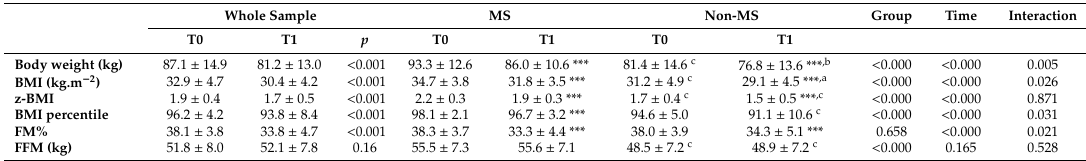
Table 1. Whole sample and MS vs. non-MS anthropometric and body composition changed from baseline to T1. WholeSample MS Non-MS Group Time